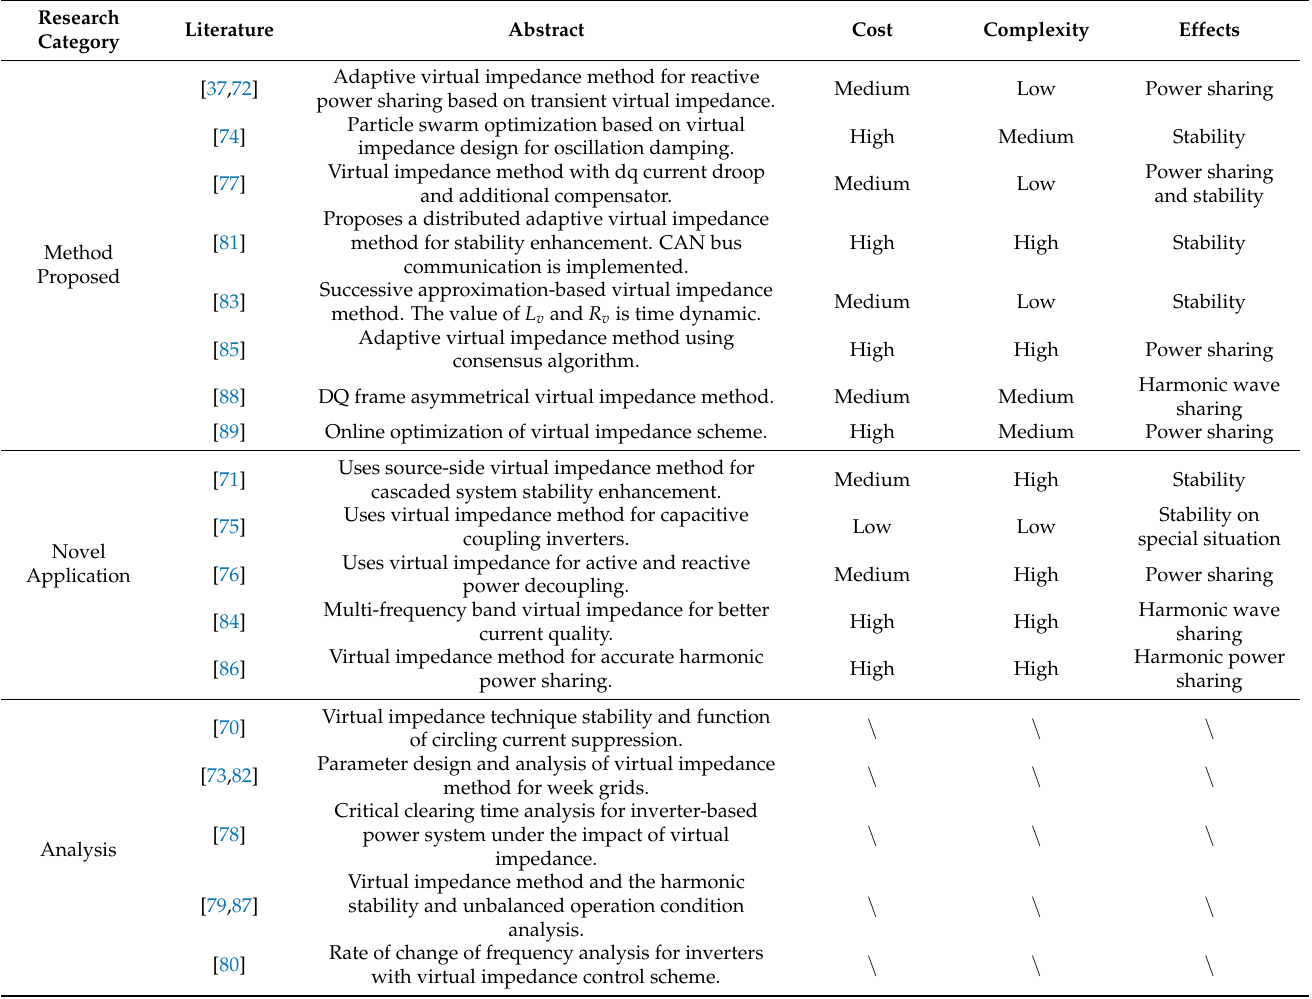
Table 2. Review list of research on virtual impedance